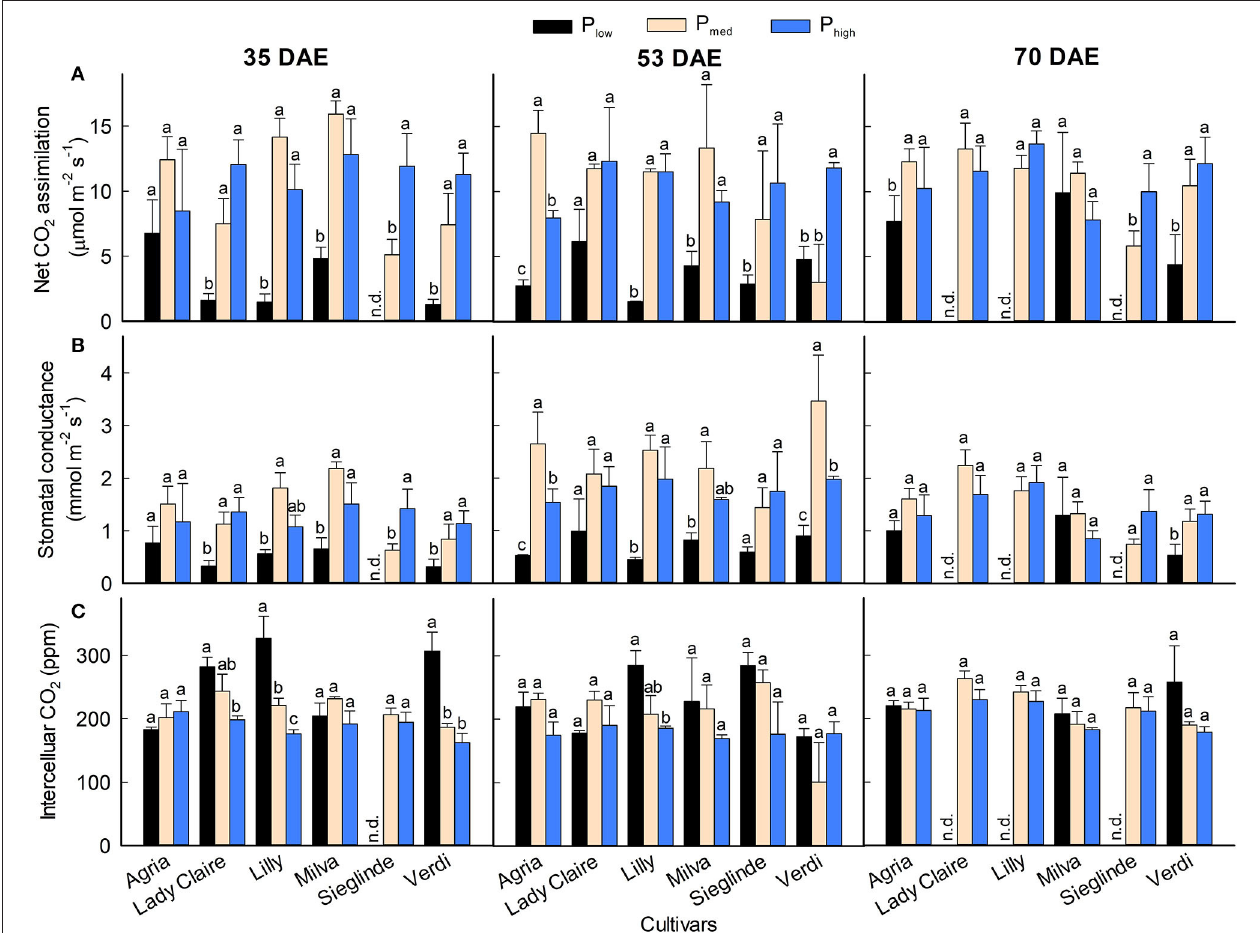
FIGURE 4 | (A) CO 2 assimilation, (B) stomatal conductance, and (C) intercellular CO 2 concentration of potato cultivars with the application of P low , P med , and P high . Different letters in lowercase indicate a significant difference between P treatments of each cultivar by Tukey’s HSD test at p < 0.05. Error bar represents SE of